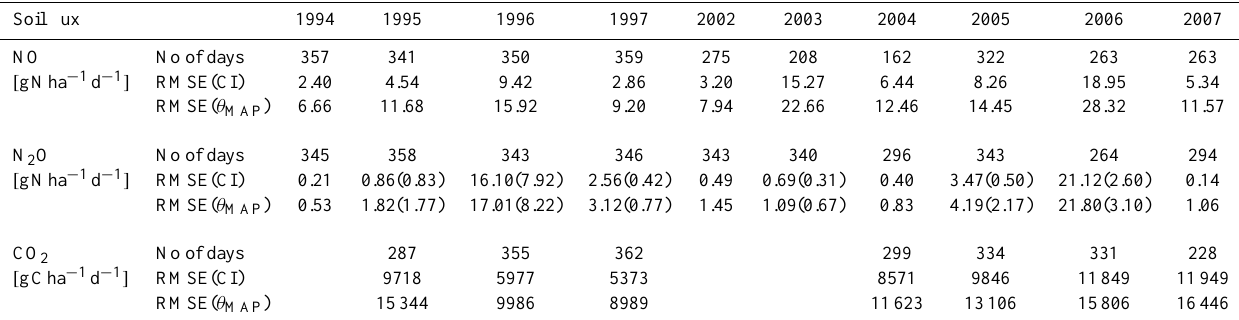
Table 4. Root-mean-squared error (RMSE) per year and soil-atmosphere gas-flux for the best simulation (RMSE( θ MAP )) and the distribu- tion of the gas-flux simulations. The minimal distance to the 99% credible intervals was used to calculate the RMSE of the distribution (RMSE(CI)). Values in brackets are calculated using simulated emissions after freeze-thaw events. Soil